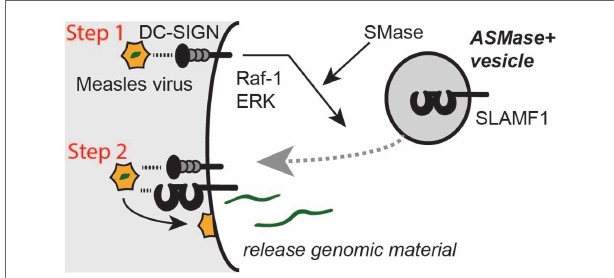
FiGURe 6 | Measles virus actively recruits its entry receptors Slamf1 to the cell surface. Binding of the lectin receptor DC-SIGN to a Measles virus particle induces a signaling cascade that involves Raf-1 and ERK and requires the activation of acidic SMase to induce a membrane trafficking event. Slamf1 + intracellular vesicles are recruited to the plasma membrane and fuse. This releases Slamf1 to the plasma membrane where Measles viral MV-H protein can bind to it to induce a fusion event between the viral membrane and the plasma membrane, consequently resulting in the delivery of the viral genomic material to the